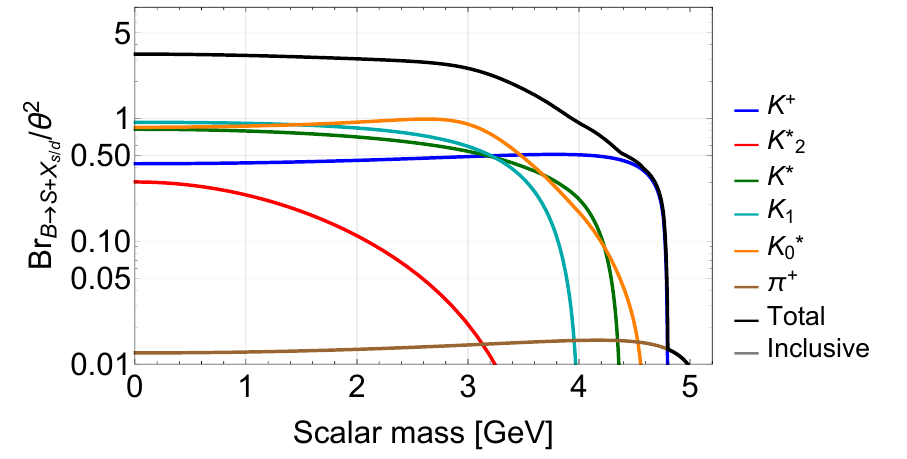
Figure 5 . Branching ratios of the 2-body decays B + SX s=d , where X q is a hadron that contains ! a quark q . By the K (cid:3) channel, we denote the sum of the branching ratios for K (cid:3) (892), K (cid:3) (1410), | for K (cid:3) (700), K (cid:3) (1430), and by K 1 | for K 1 (1270), K 1 (1400). K (cid:3) (1680) (cid:12)nal states, by K (cid:3) 0 0 0 The \Inclusive" line corresponds to the branching ratio (2.7) obtained using the free quark model. For experiments with smaller energies like, e.g., DUNE the dominant channel is the direct production of scalars in proton bremsstrahlung and in